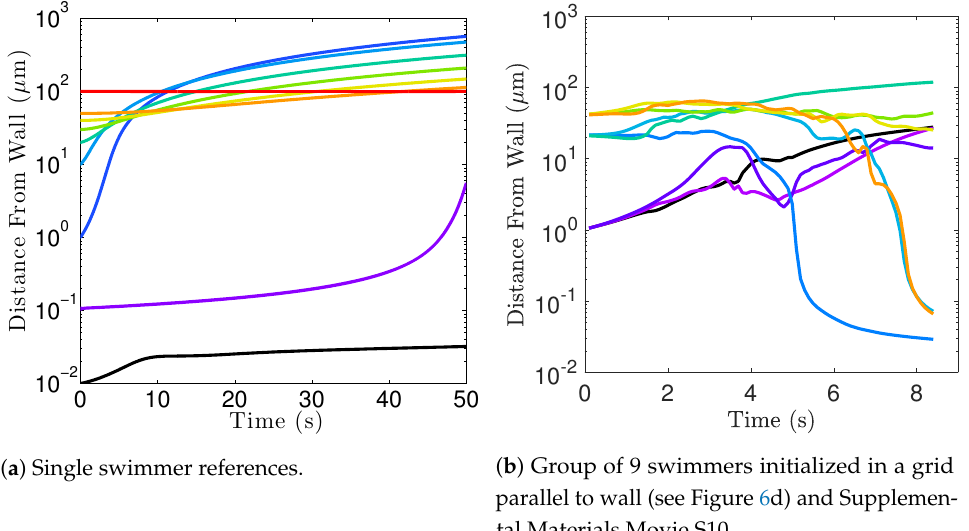
( b ) Group of 9 swimmers initialized in a grid parallel to wall (see Figure 6d) and Supplemen- tal Materials Movie S10. Figure 19. Distance between the head point of the flagellum and the wall over time for swimmers initialized in parallel planes to the wall. In ( a ), individual flagella are initialized at various heights away from the wall, with the flagellar beat plane parallel to the wall (each curve is a simulation of one solitary flagellum and results are overlaid). All flagella tend to move away from the wall over time, regardless of how far they start from the wall. In ( b ), we show the results of a single simulation of a group of 9 flagella, all initiated with beat planes parallel to the surface, in phase but separated from each other by a distance of 20 µ m. Here, positions of heads are plotted once per beat to remove the zig-zag pattern that can occur due to the periodic undulation of flagella (1 beat = 0.1 s). Notice that some sperm seem to become trapped near the wall, in contrast with the individual swimmers in panel ( a ). Color of curves in panel ( b ) indicates data for flagellum of matching color from Figure